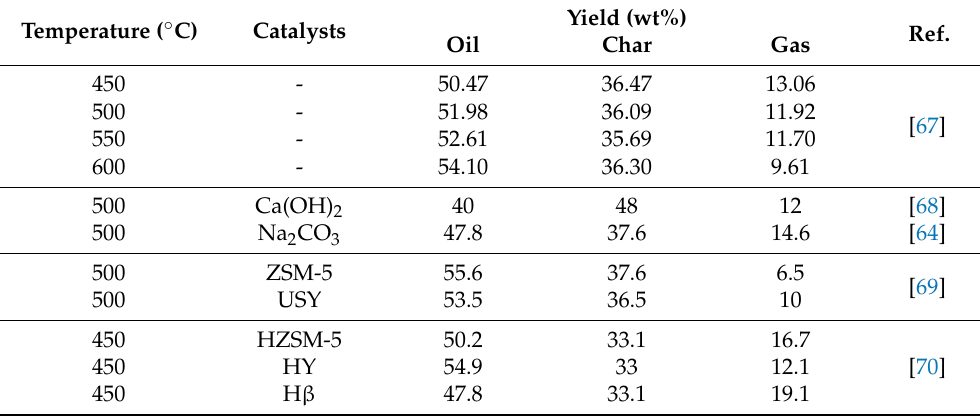
Table 2. Distribution of pyrolysis products under different